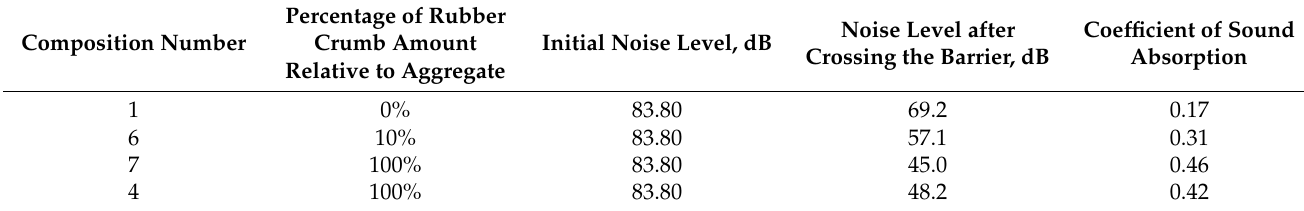
Table 4. Sound absorption of developed composites.